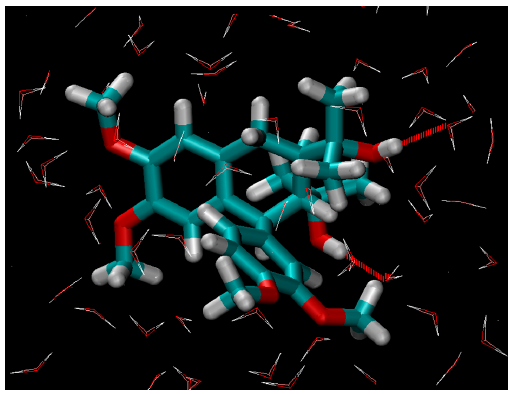
Figure 2. Hydrogen bonding of tetramethyl 1,4-diol with TIP4P water (hydrogen atoms white, carbon atoms cyan, oxygen atoms red; red dashed lines indicate hydrogen bonds).